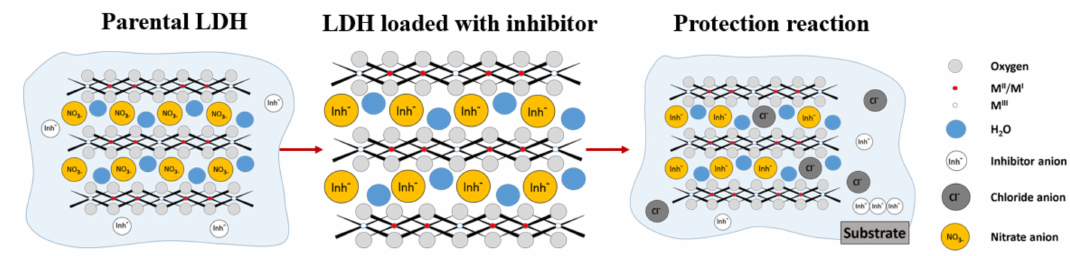
Figure 4. The schematic presentation of LDH structure, the anionic exchange with inhibitor ion, and their triggered release for corrosion protection. Adapted with permission from [34]; Copyright 2020 Elsevier.